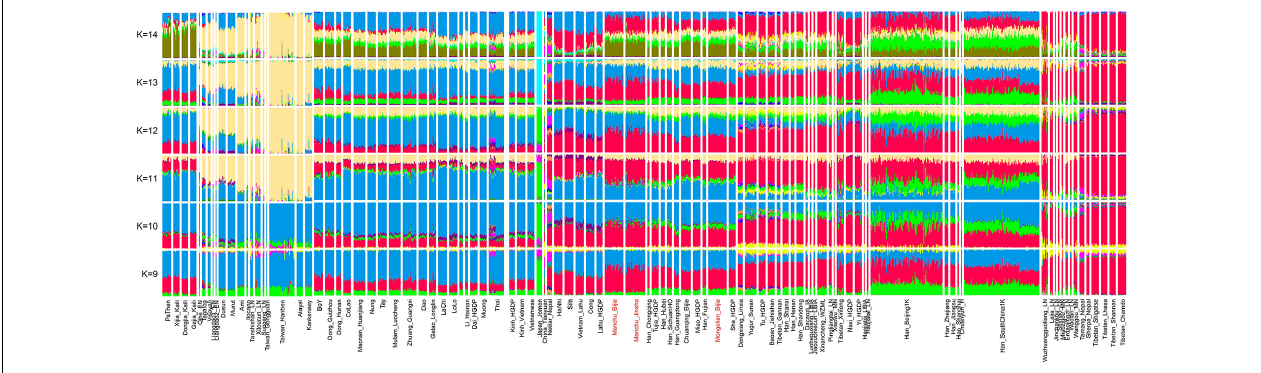
FIGURE 2 | Results of model-based ADMIXTURE clustering analysis. Clustering patterns were visualized with the predefined ancestral sources ranging from 9 to 14 among East Asians (K: 9–14). Here, we can identify late Neolithic to Iron Age Taiwan Hanben dominant ancestry widely distributed in Austronesian speakers, LoChi or Lolo-dominant ancestry maximized in Tai-Kadai–speaking populations, Tibetan-dominant ancestry widely distributed in Tibeto-Burman–speaking populations, and others, all of these ancestries were color-coded by different colors.